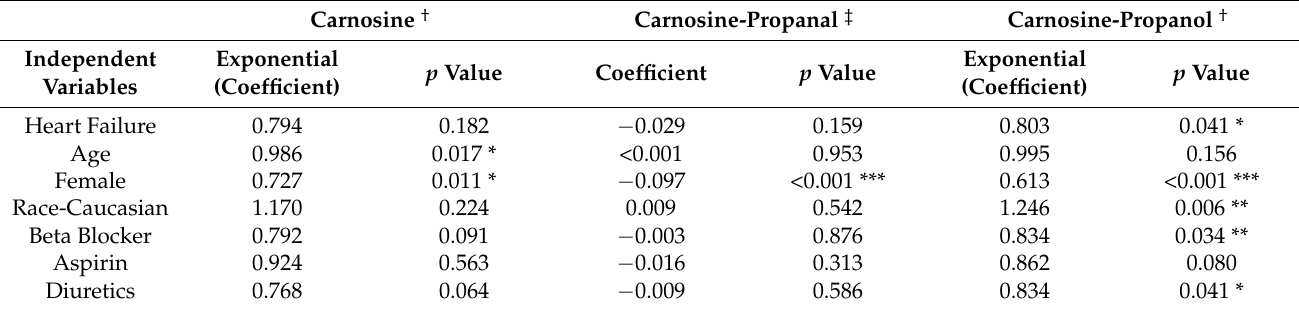
Table 6. Association of Carnosine, Carnosine-Propanal, and Carnosine-Propanol with Heart Failure. Carnosine † Carnosine-Propanal ‡ Carnosine-Propanol